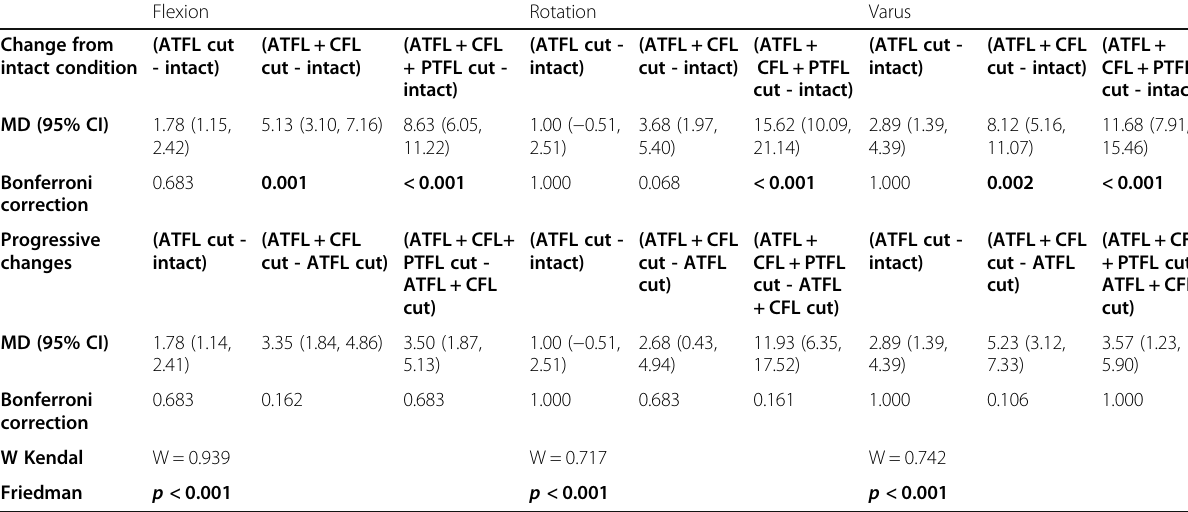
Table 1 Changes of progressive ligament sectioning Flexion Rotation Varus